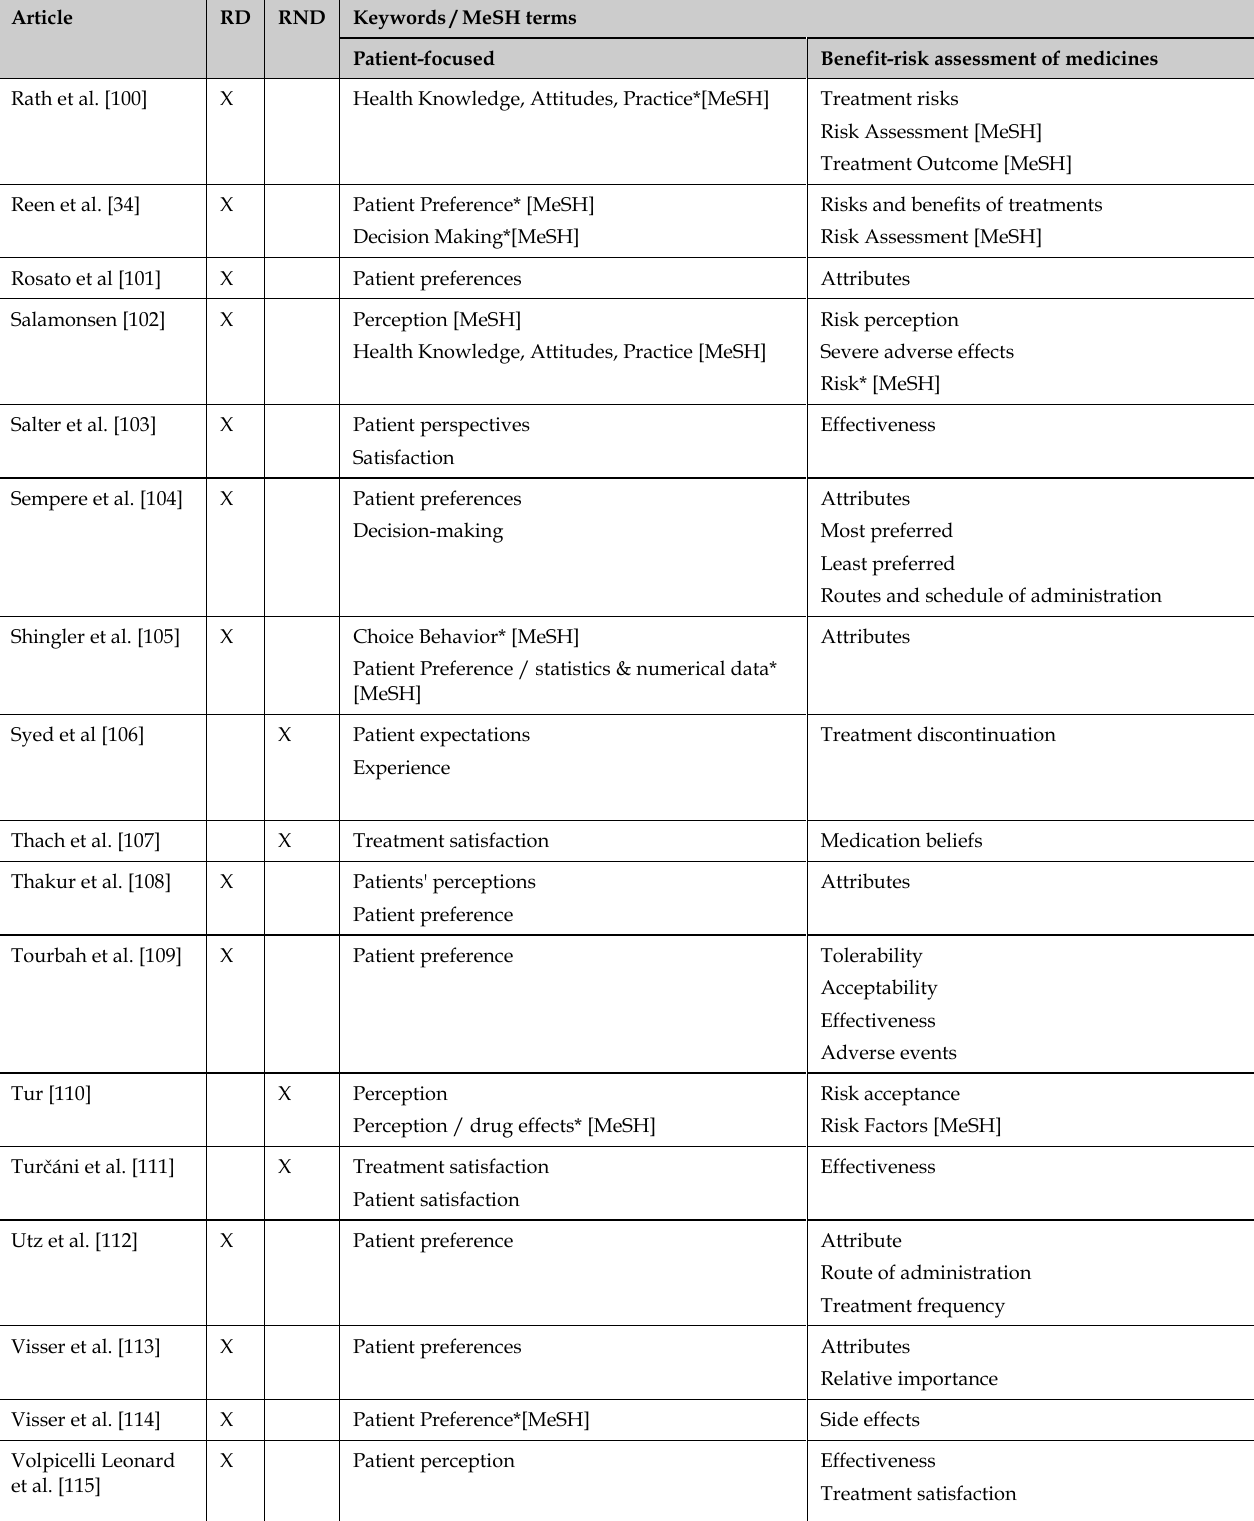
Table 3 Relevant articles on multiple sclerosis patients’ preferences regarding their medicines detected (RD) and not detected (RND) by the search strategy with corresponding keywords and MeSH terms